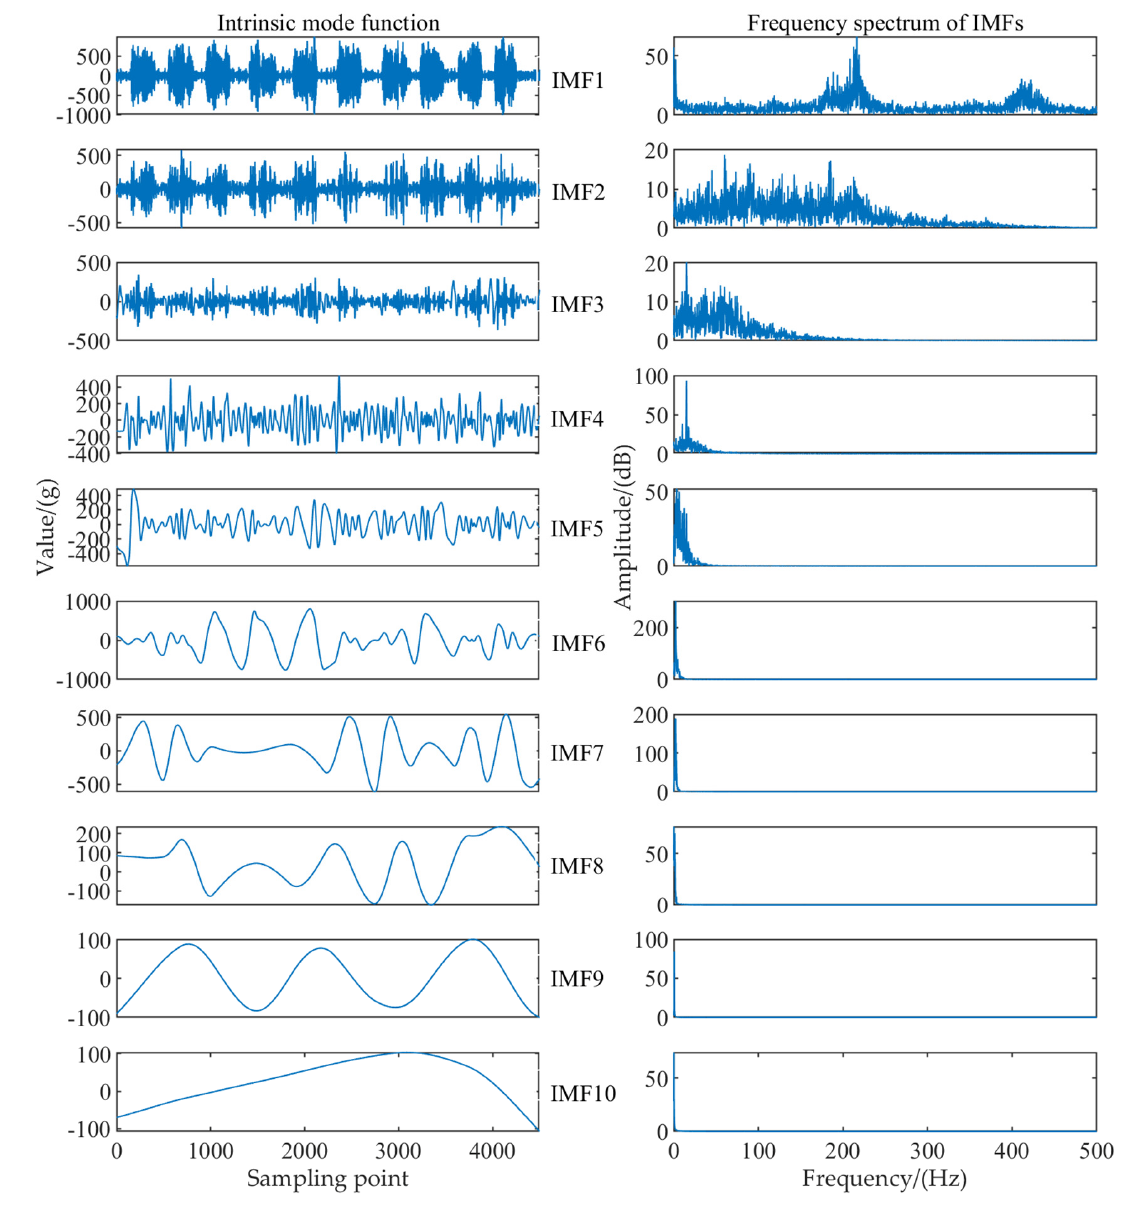
Figure A2. Spectrum diagram of loaded signal.